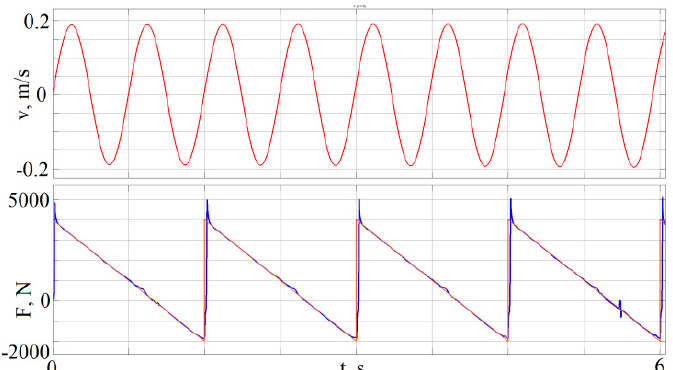
Figure 12. Desired force as a delayed sine wave. Top: velocity of the rod; bottom: force on the rod (red—desired, blue—actual).